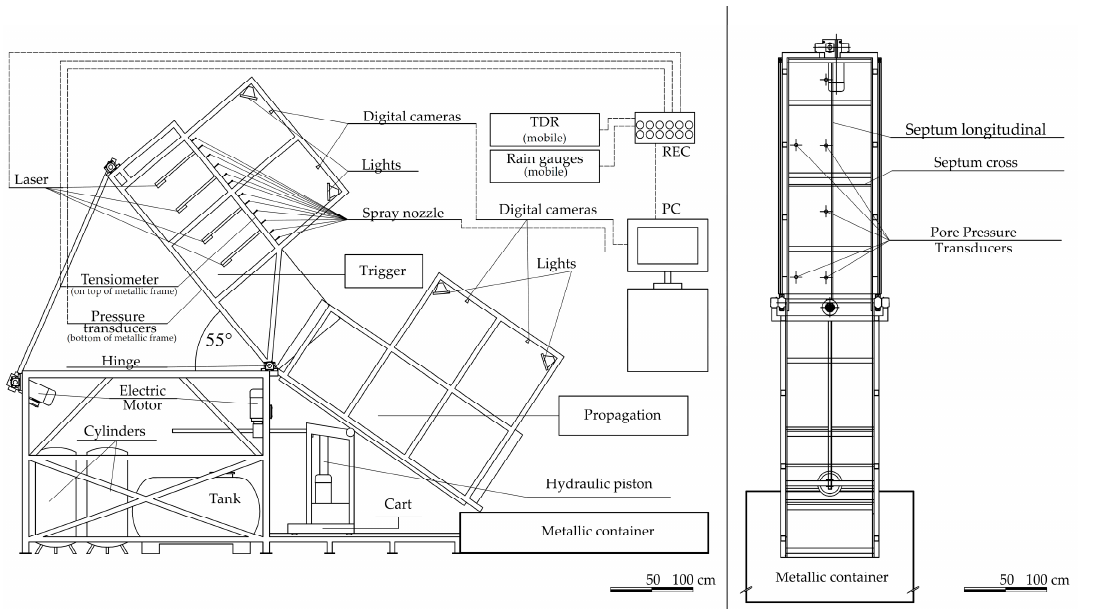
Figure 1. Section and plan of the mechanical components of flume.